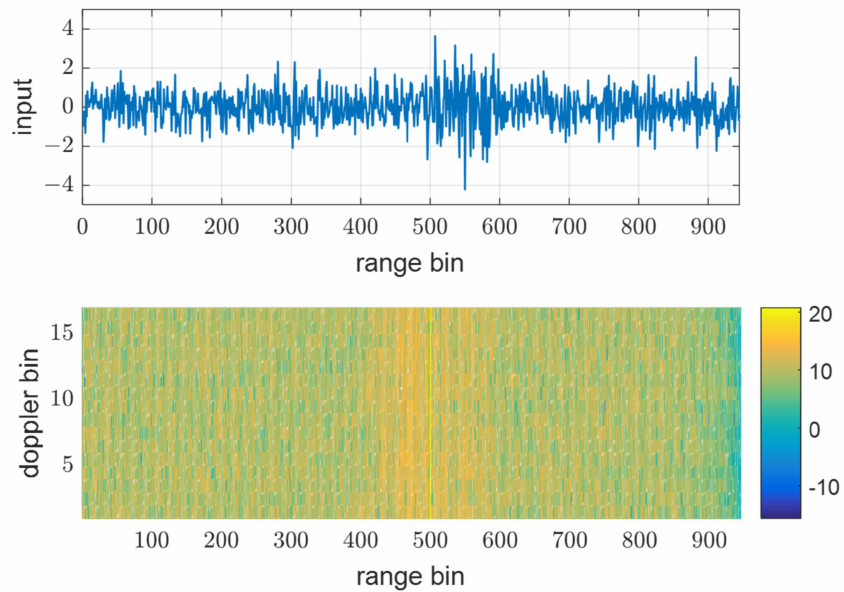
Figure 8. Input data of 10th pulse and matched filter out, y 1,3 using the same PRF at SNR i = 0 dB.